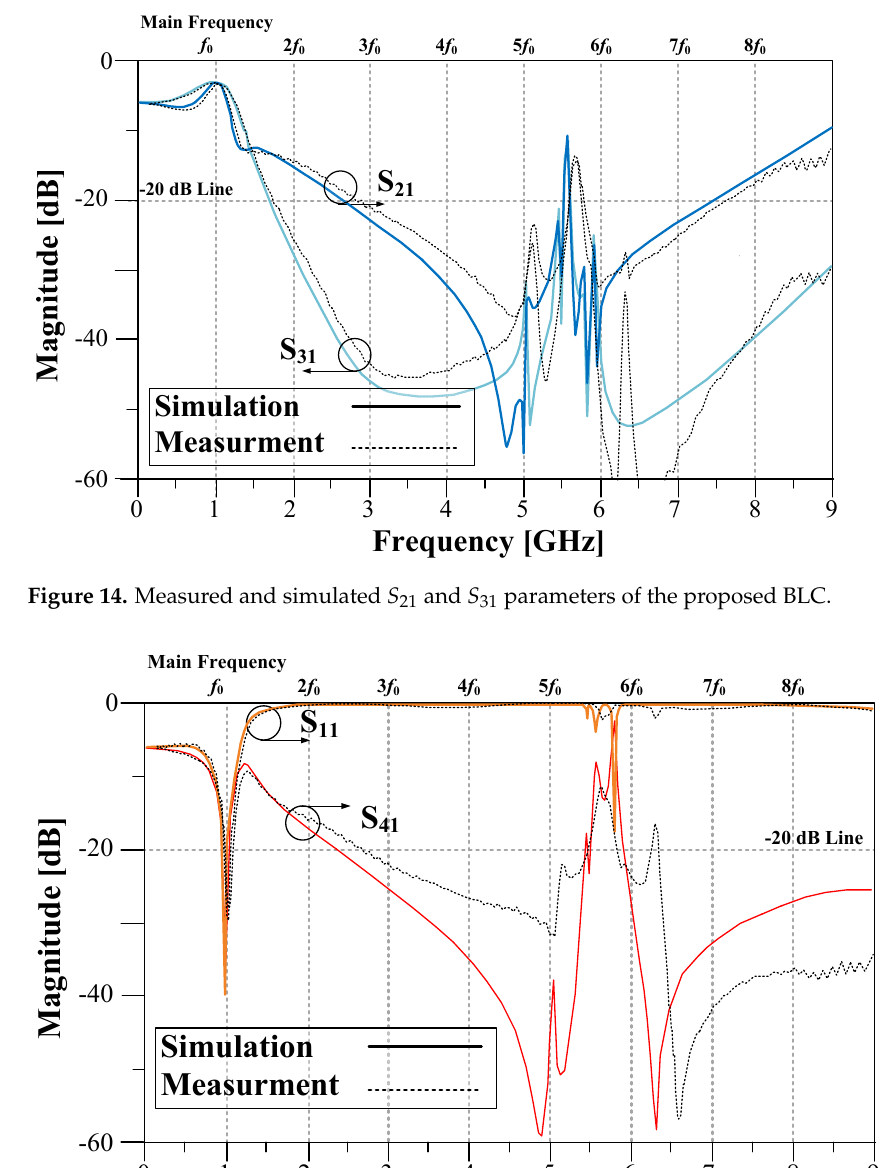
Figure 16. In-band simulated and measured S-parameters of the proposed BLC. The result of the in-band phase difference is depicted in Figure 17. The measured phase difference of the presented BLC is less than 90 ± 0.5° at the main frequency. Moreo- ver, the phase difference is flat, and its value is near 90° at the operating bandwidth.